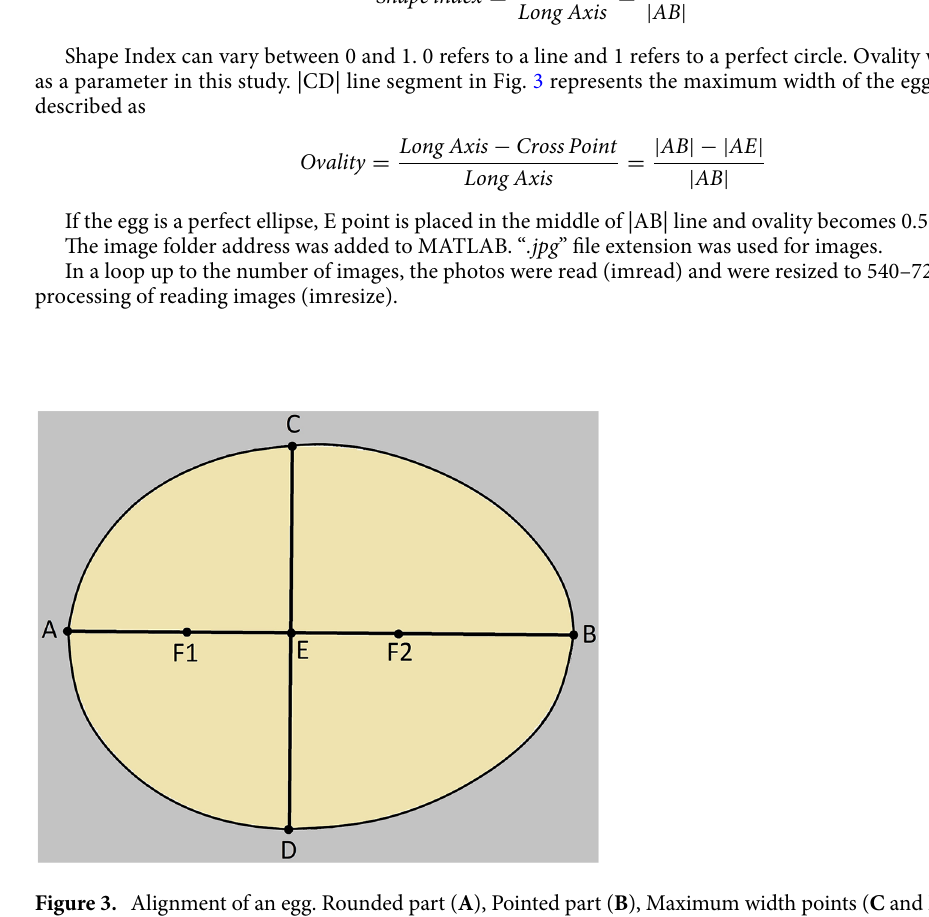
Figure 3. Alignment of an egg. Rounded part ( A ), Pointed part ( B ), Maximum width points ( C and D ), Focal Points (F1 and F2), Cross Point ( E